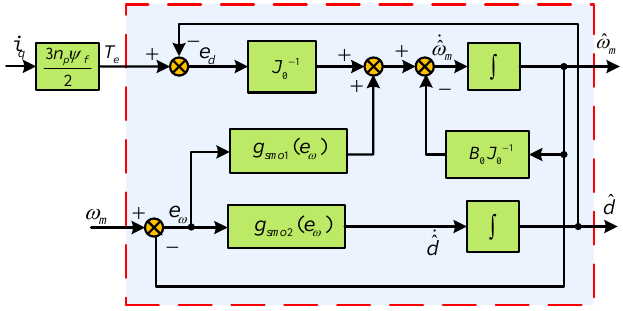
Figure 3. Block diagram of the extended sliding mode observer.